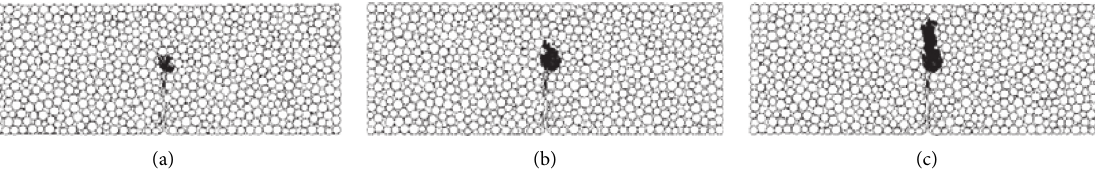
Figure 14: Microcracks distribution in SC3PB specimen (C1). (a) Crack initiation. (b) Crack growth. (c) Sample failure.